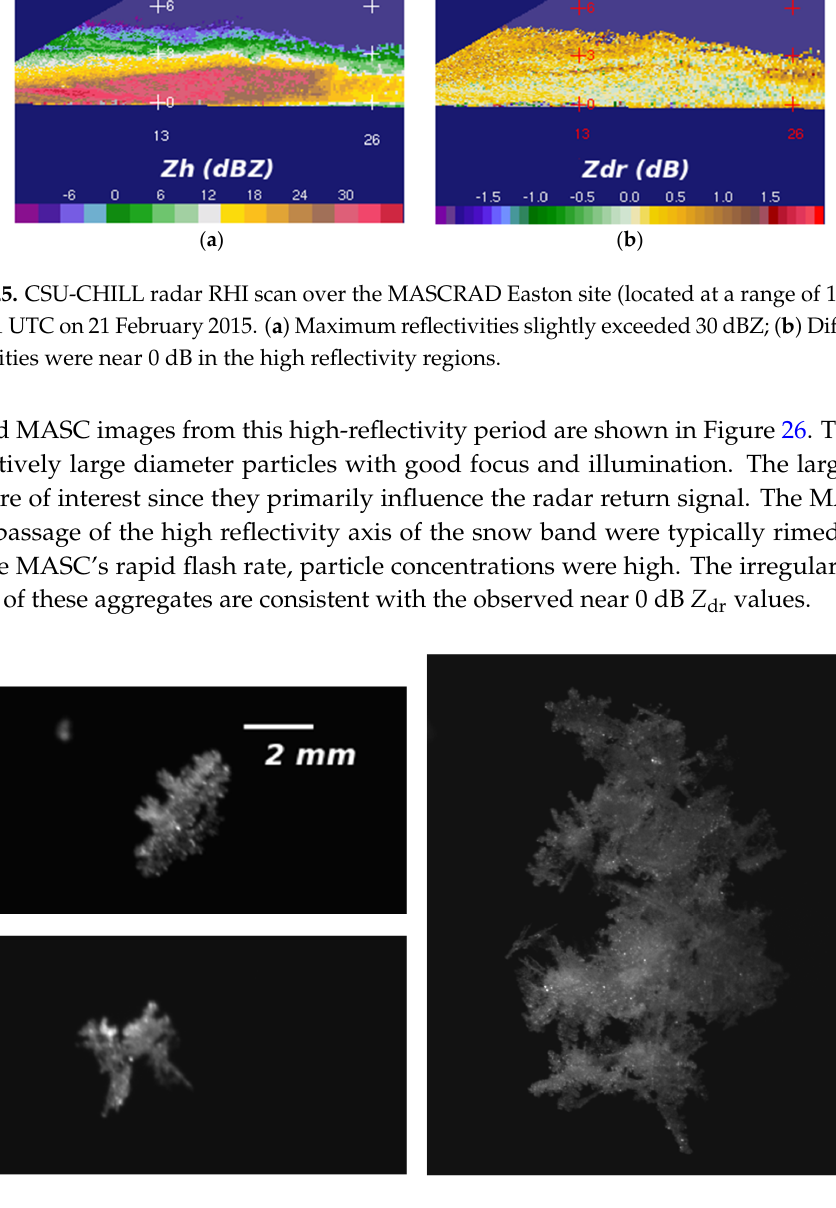
Figure 26. Selected MASC images starting at 21:41 UTC on 21 February 2015.